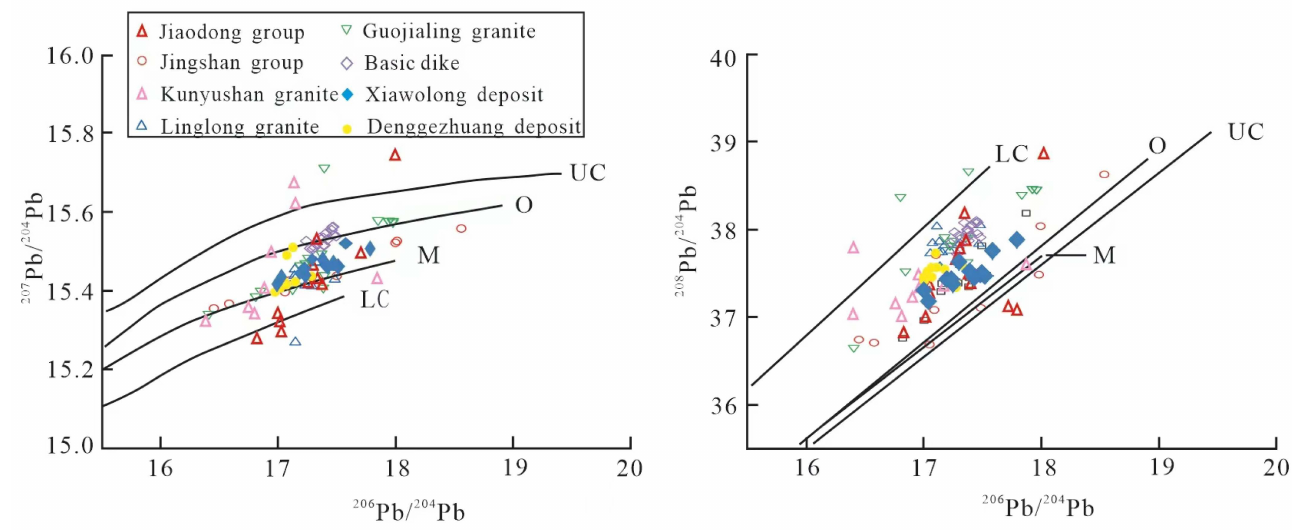
Figure 12. Pb isotopic compositions of pyrite in the Xiawolong gold deposit. The evolution lines for major geological units are from Zartman and Haines [66]. Adapted with permission from Ref. [66]. 1988, Elsevier. UC, upper crust; O, orogen; M, mantle; LC, lower